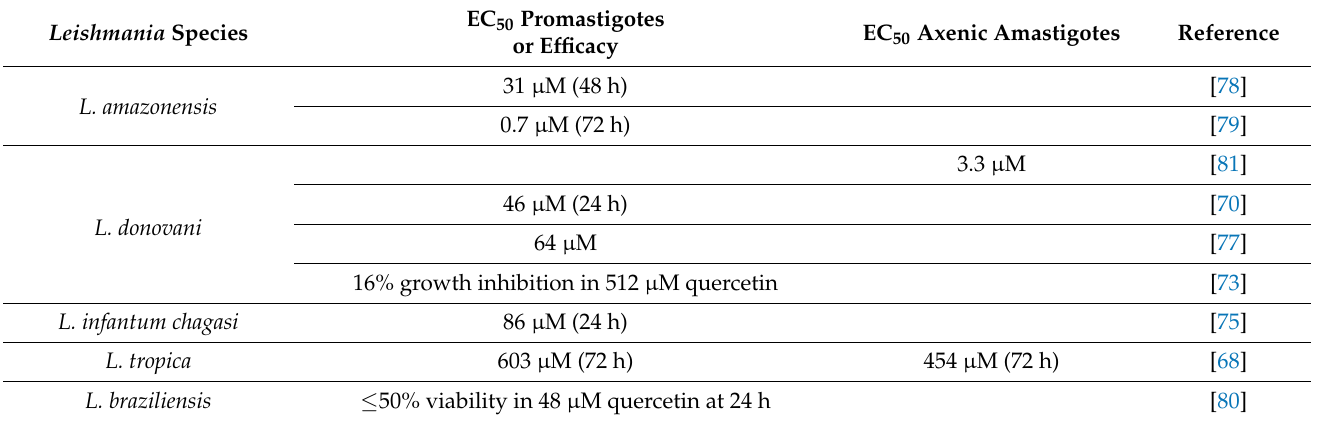
Table 3. In vitro anti-leishmanial activity of quercetin.